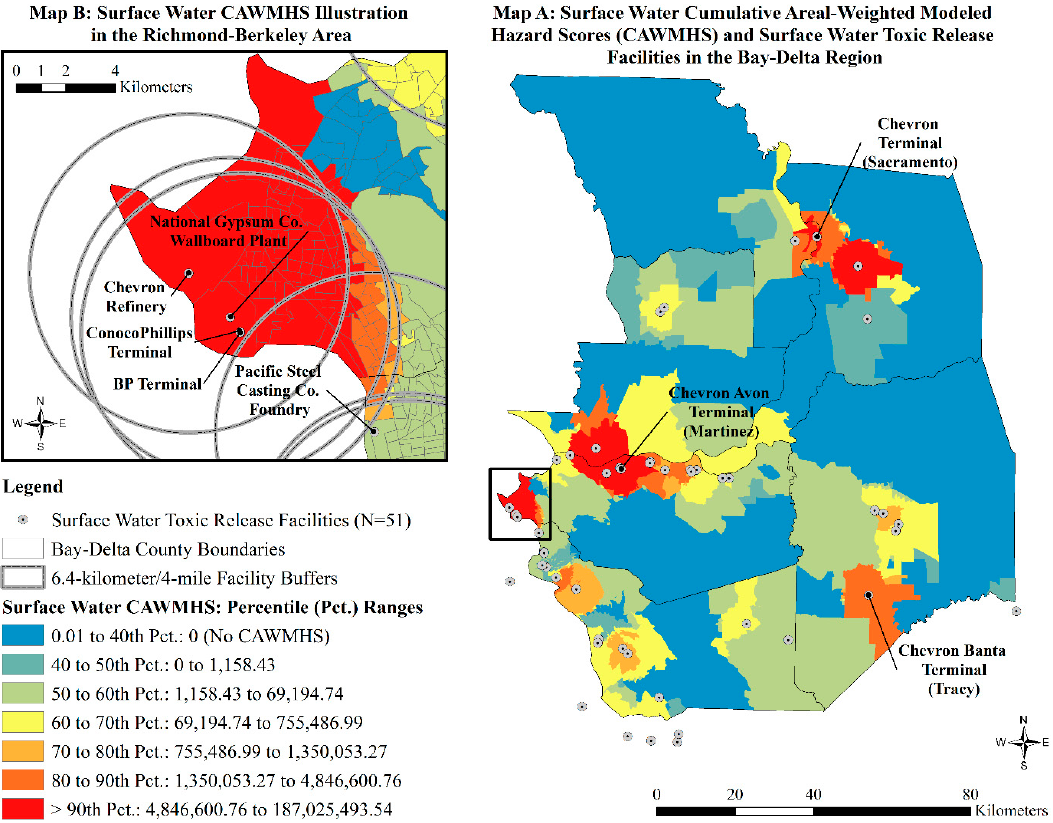
Figure 7. The spatial distribution of percentile ranges for surface water CAWMHS associated with surface water toxic releases from 2000 to 2006 in Map ( A ) the Bay-Delta region (N = 3073) and Map ( B ) in the Richmond-Berkeley area.